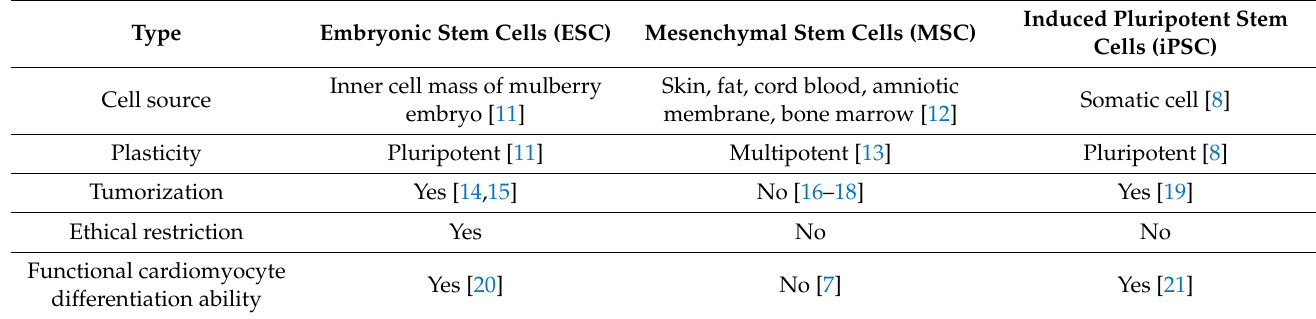
Table 1. Characteristics comparison of each types stem